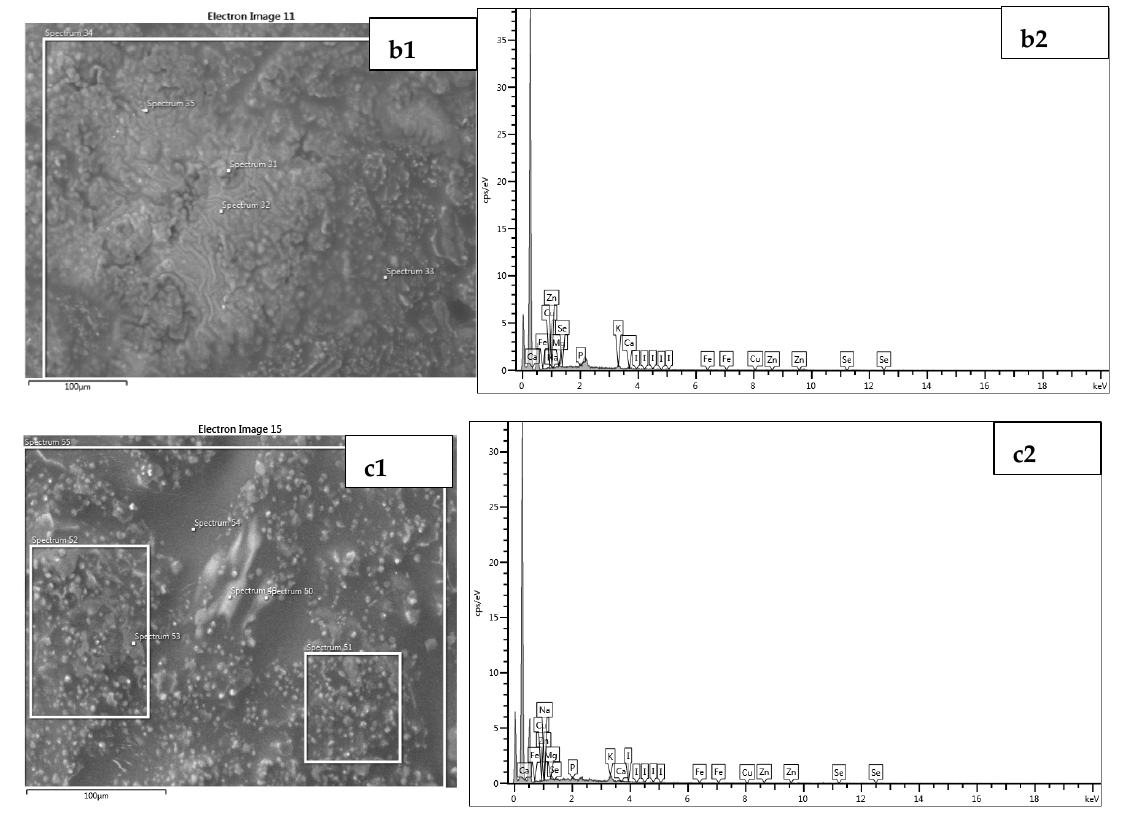
Figure 4. EDX characterization spectrum obtained for BAMOnut snack bars: ( a ) BAMOnut enriched with oats and 3% BAMOLP, ( b ) BAMOnut enriched with millet and 2% BAMOLP, ( c ) BAMOnut enriched with oats, millet and 5% BAMOLP. All the micrographs are on a scale of 100 µm. Visible peaks confirm the presence of sodium, magnesium, phosphorous, potassium, calcium, iron, nickel, copper, zinc, selenium, iodine.